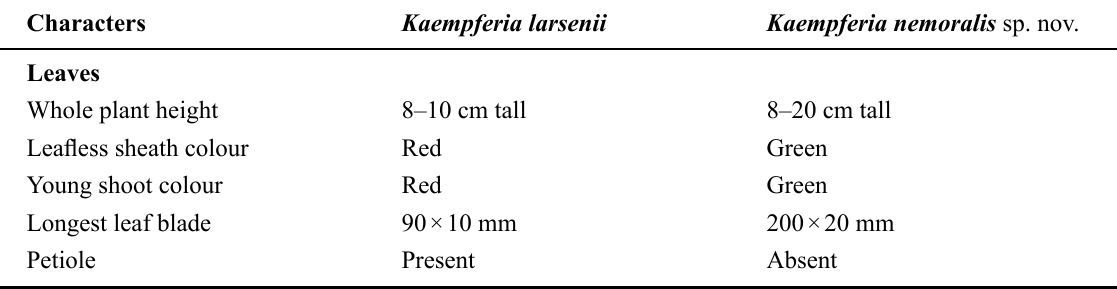
Table 1. Comparison of the vegetative parts of Kaempferia larsenii Sirirugsa and Kaempferia nemoralis Insis. sp. nov.